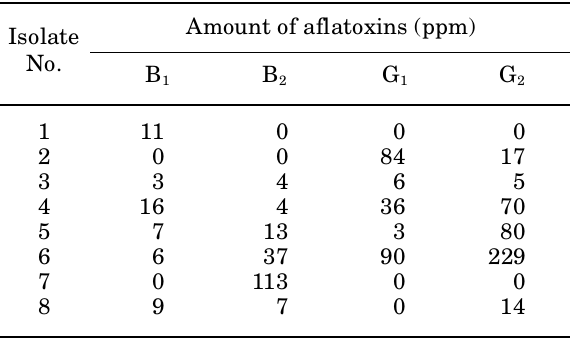
Table 3. Aflatoxins produced by A. flavus isolates ob- tained from herbal plants. Amount of aflatoxins (ppm) Isolate